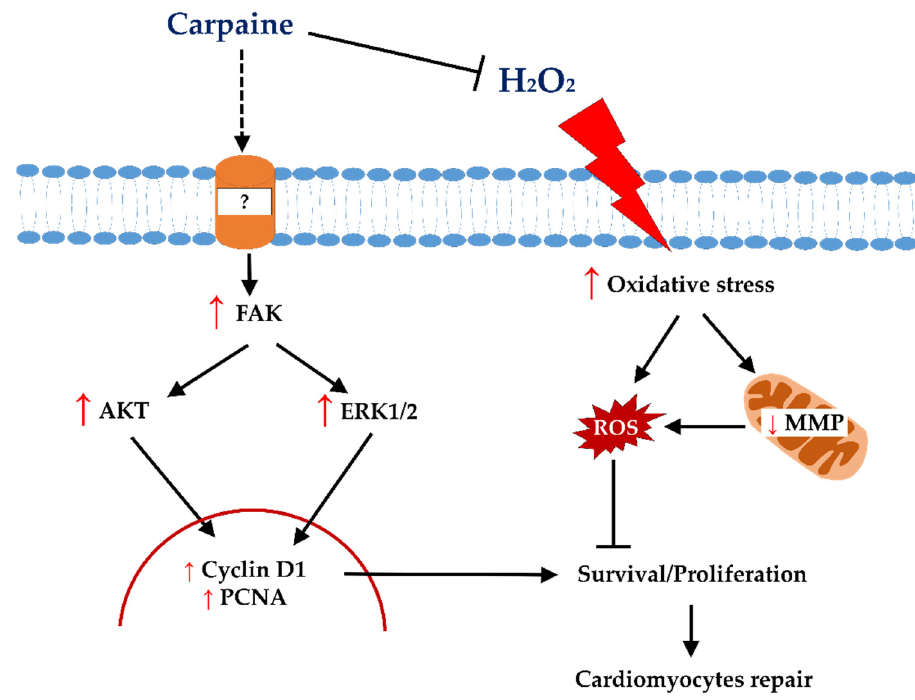
Figure 5. Proposed proliferative and protective signalling of carpaine in H9c2 cells. Carpaine induces cardiomyocyte proliferation via the FAK-ERK and FAK-AKT pathways and provides protection against H2O2-induced oxidative stress in H9c2 cells.